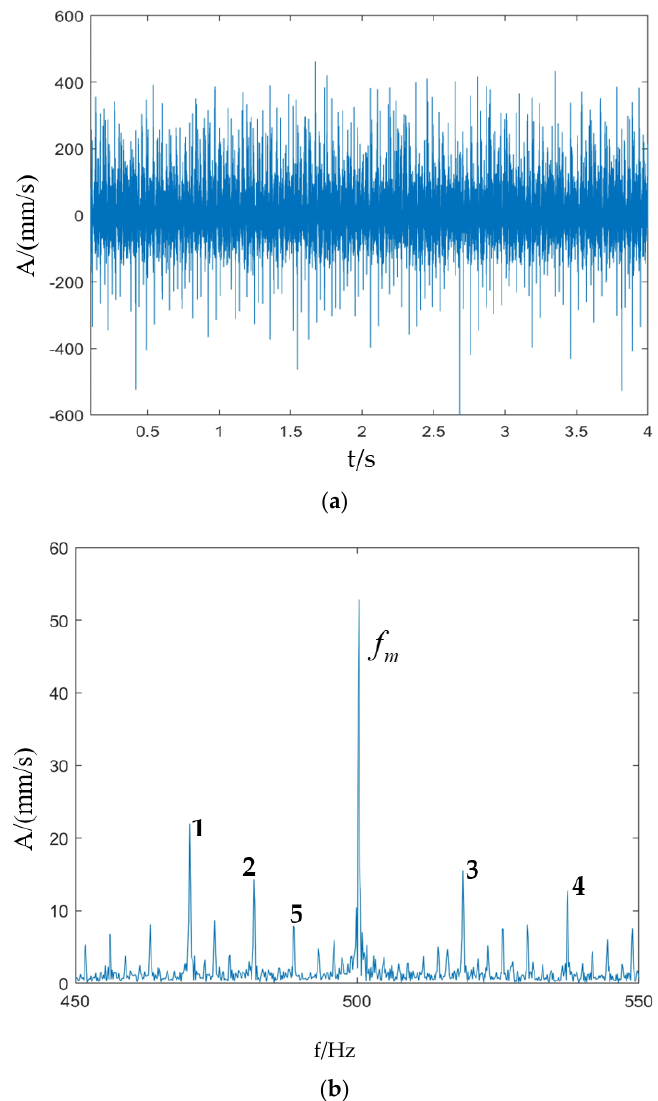
Figure 8. Simulated vibration signal of sun gear missing teeth and planetary gear pitting: ( a ) Time domain waveform; ( b ) Fourier spectrum.